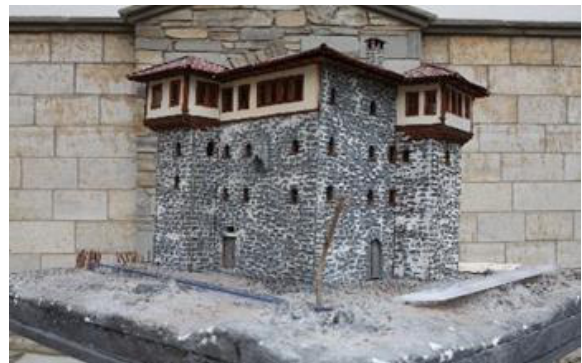
Figure 1: Model maquette of Tower House in the Folklore Museum of the Municipality of Kozani, Greece